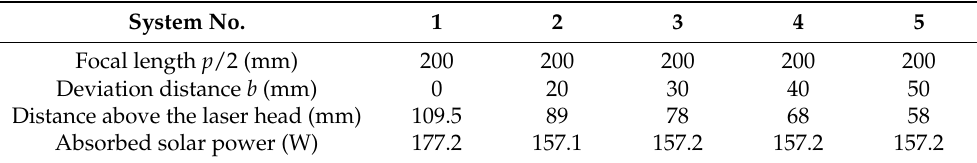
Table 1. Parameters of the modified parabolic mirror and absorbed solar power concentrated by the different primary concentrator systems and LLGL without considering the pump cavity.